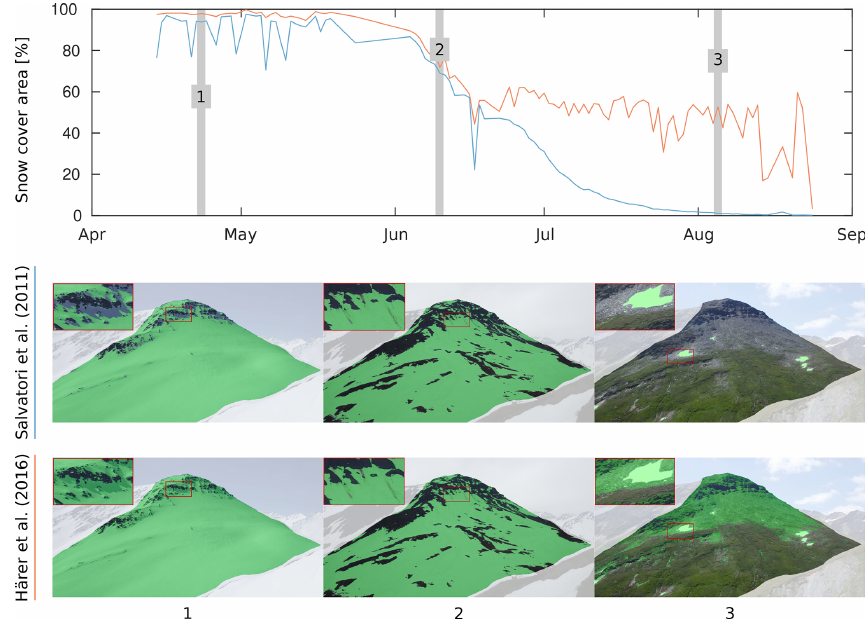
Figure 12. Percentage of snow-covered area on a mountain hill in the Furka Pass region from 14 April to 28 August 2015 using the snow classification proposed by Salvatori et al. (2011) (blue line) and Härer et al. (2016) (red line). Webcam images: Blauberg Furka Pass, © Armin Rist, Institute of Geography, University of